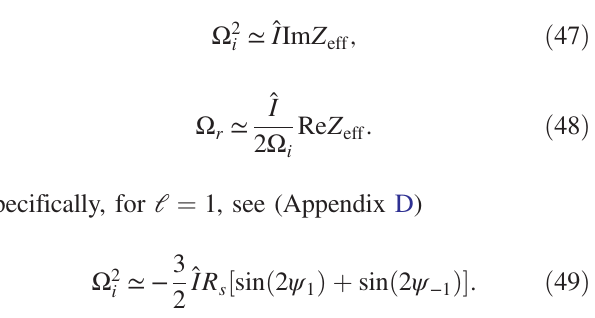
FIG. 6. Real (blue) and imaginary (red) part of the effective impedance for mode l ¼ 1 for two ALS HHCs (solid) and optimum HHCs (dashed). The picture highlights how the ALS HHCs operating tuning range is at larger angles ψ (i.e., away from the resonance peak) compared to the optimum HHCs reflecting a larger shunt impedance. The left ends of the two ranges correspond to about a factor 4 lengthening in both cases. The larger ALS-HHC Im Z is the reason for the higher eff sensitivity to the l ¼ 1 mode